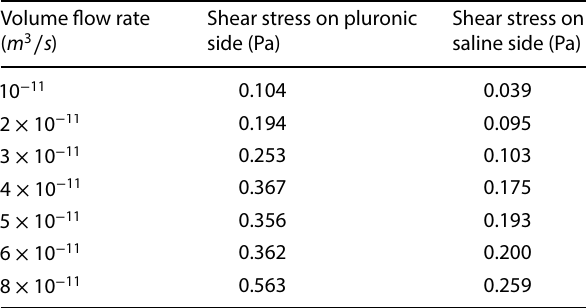
Table 3 Shear stress on both sides of the gel wall Volume flow rate ( m 3 ∕ s )